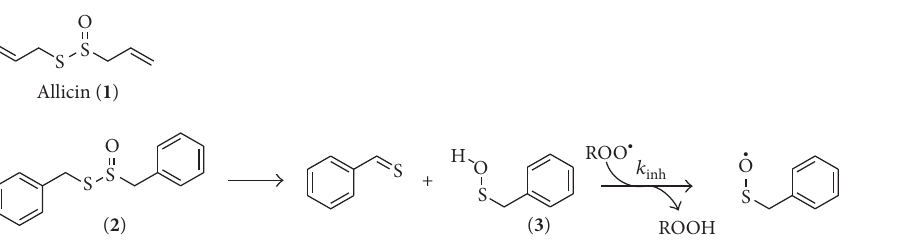
Scheme 5: Formation of the active radical-trapping sulfenic acid ( 3 ) from decomposition of benzyl phenylmethanethiosulfinate ( 2 ), an analogue of allicin ( 1 ).